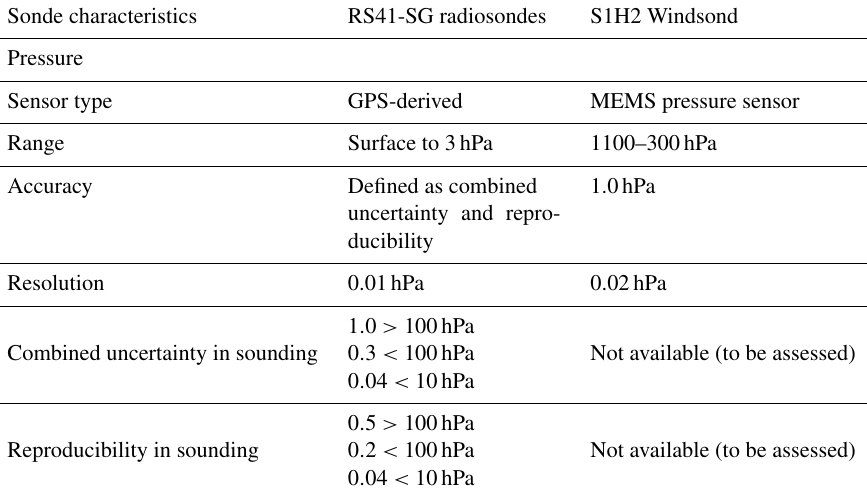
Table 4. Pressure sensor manufacturer specifications (based on Table 3 from Vaisala, 2014; SparvEmbedded, 2016).